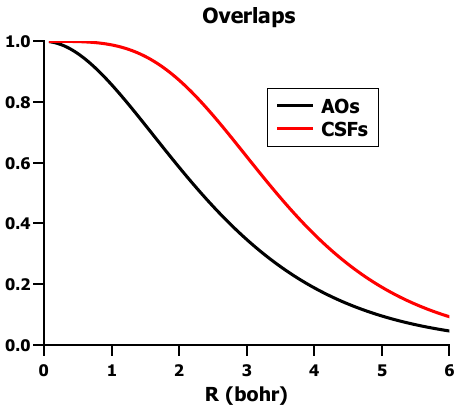
Figure 20. The overlap between the VB CSFs and between the hydrogen 1s